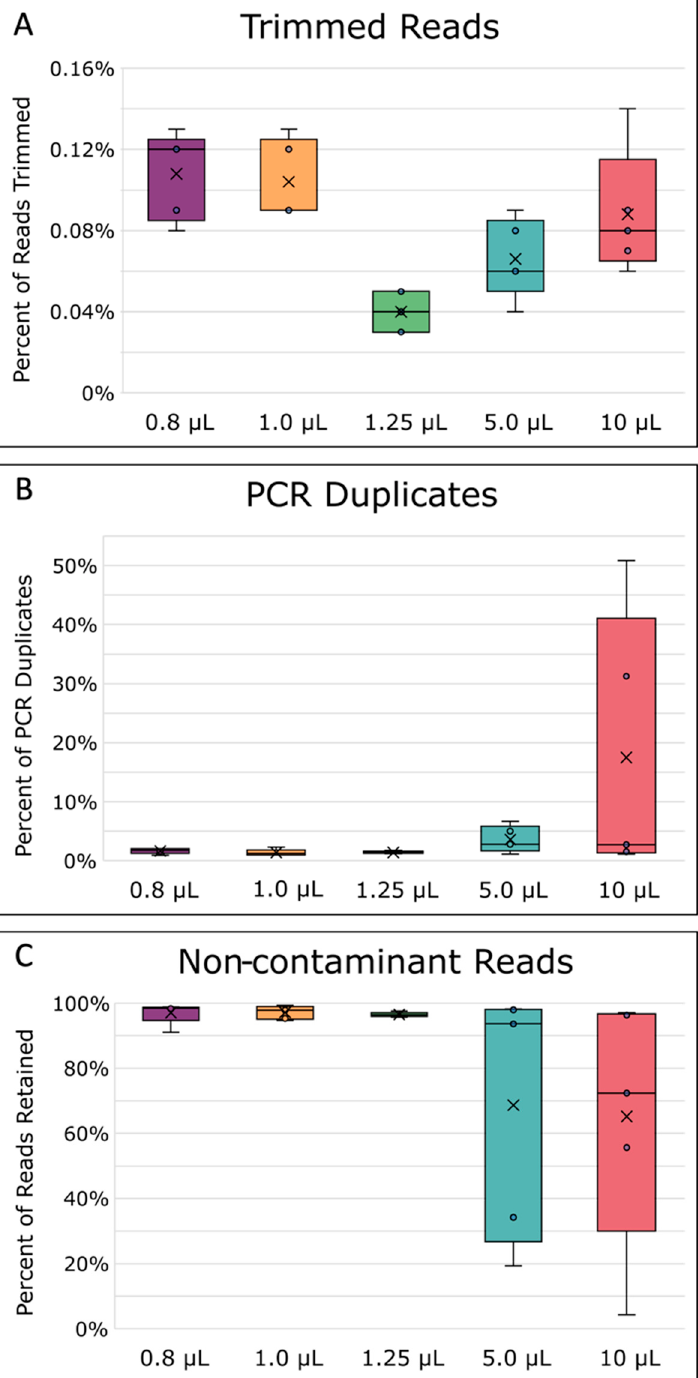
Figure 4. Read processing statistics. ( A ) Percentage of reads removed during quality trimming. ( B ) Percentage of PCR duplicates removed. ( C ) Percentage of reads kept after read contaminant filtering. The boxes’ middle line represents the median, and the x represents the mean. Five replicates were used for calculation.